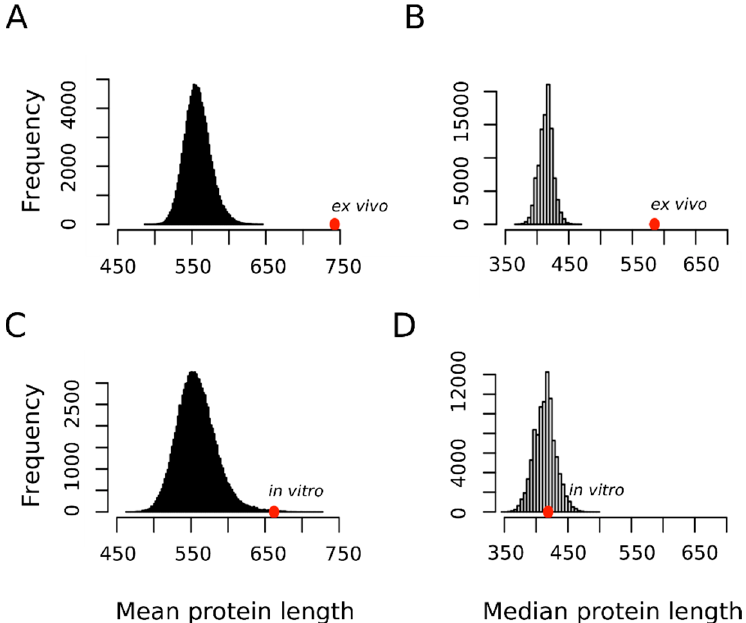
Figure 4. Mean and median protein length distribution. Empirical distributions of mean and median protein length for 100,000 random samples from the human proteome. For each sample, both the mean ( A , C ) and the median ( B , D ) protein length were obtained by averaging across either 1113 ( A , B ) or 503 ( C , D ) proteins randomly chosen from the human proteome. The positions of the mean and median values computed for the set of 1113 proteins oxidized ex vivo ( A , B ) and for the set of 503 proteins oxidized in vitro ( C , D ) are indicated with the red circles.